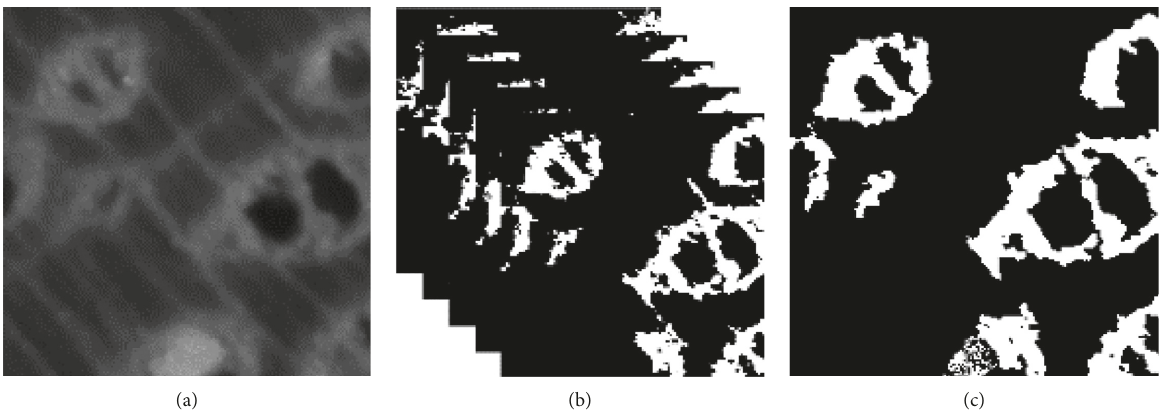
Figure 3: The wood vessels’ peripheral region extraction with mathematical morphology: (a) the hyperspectral 56 th band image; (b) the binary image cube of M × N × 128 dimensions; (c) the binary image E